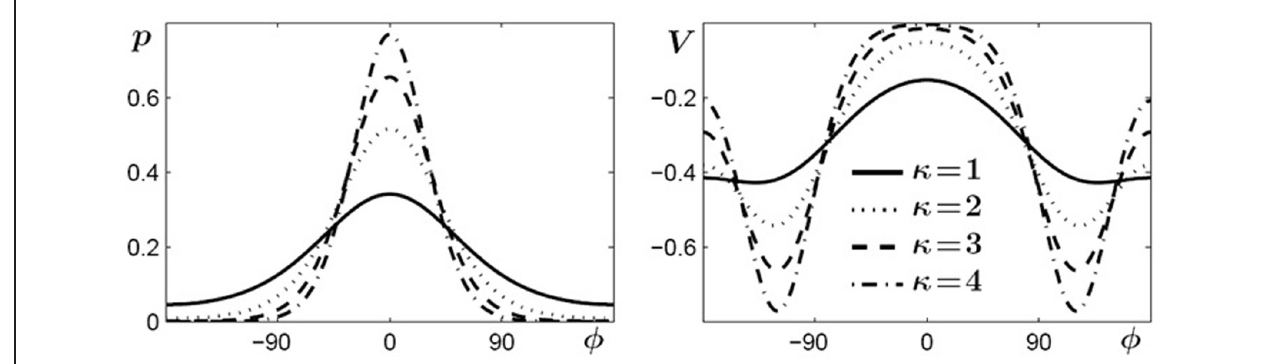
FIGURE 3 | Von Mises distributions and their use in the potential function (3). Left : periodic distributions for different values of κ . Right : two-well functions used in (3) for different values of κ and for a learned pattern of ψ = ± 120 ◦ .